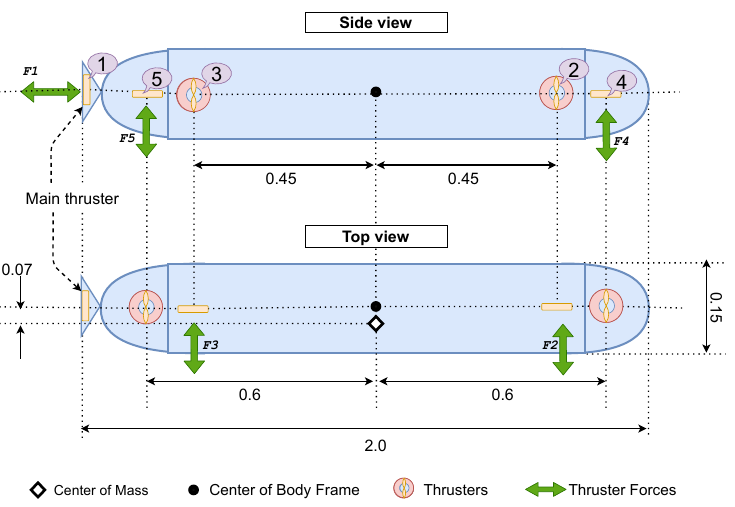
Figure 6. AUV: X300 model and allocation of thrusters.